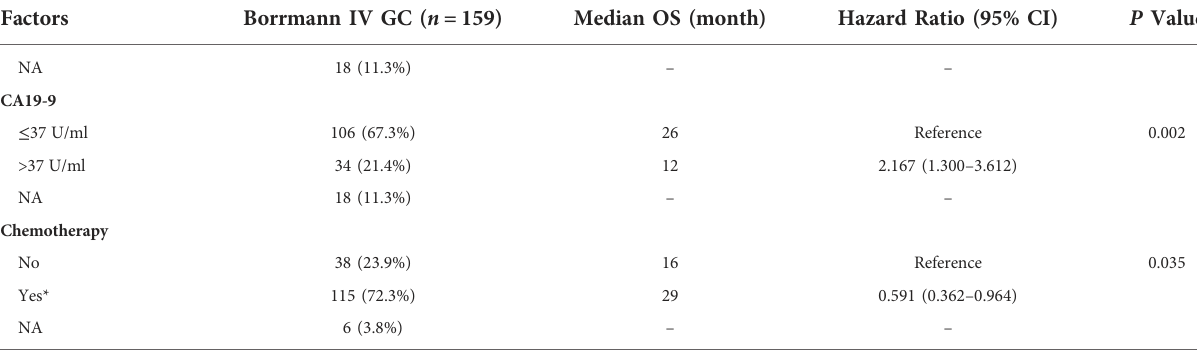
Abbreviations: NA, not available. # R1, postoperative pathology showed positive surgical margin. *Including the patients received neoadjuvant chemotherapy ( n =25) and adjuvant chemotherapy ( n